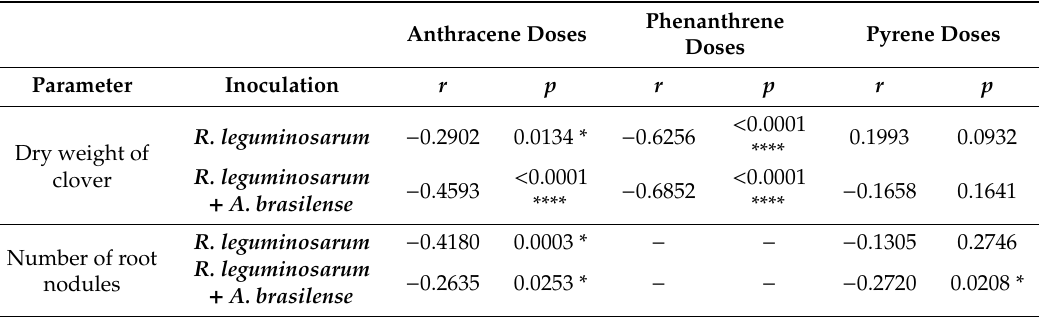
Table 5. Spearman’s correlation coe ffi cients between observed parameters (average) of red clover and doses of PAHs: anthracene, phenanthrene, and pyrene for eight using strains of Rhizobium . Significant levels for the Spearman’s rank coe ffi cients are indicated at the * p ≤ 0.05 and **** p ≤ 0.0001